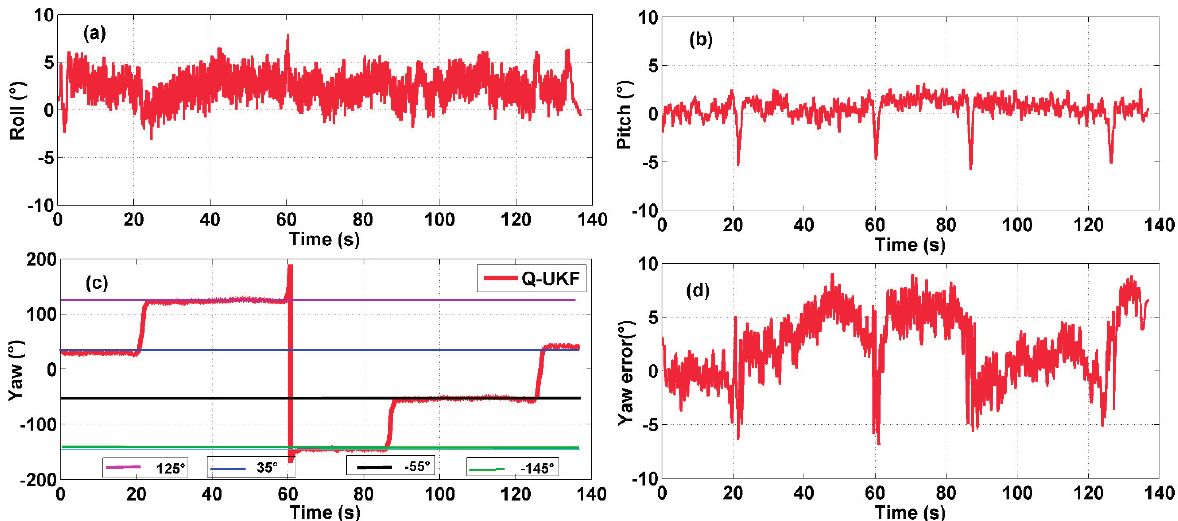
Figure 9. Multi-sensor system on a quadrotor test: ( a ) roll angle; ( b ) pitch angle; ( c ) yaw angle; ( d ) yaw angle error.